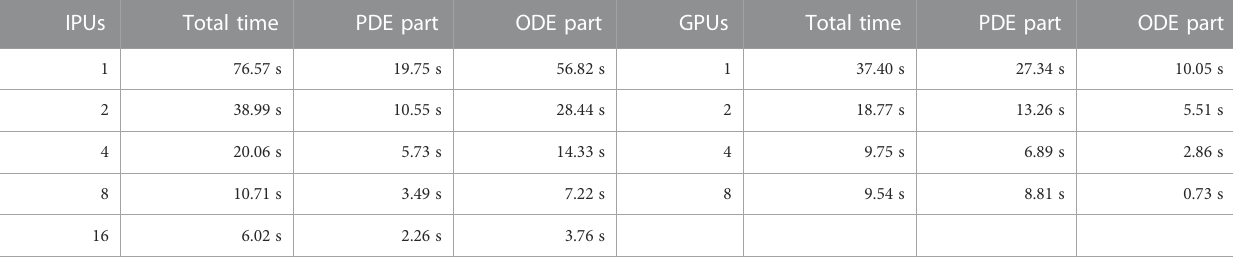
TABLE 3 Performance comparison between GC200 IPUs and A100 GPUs related to a monodomainsimulation using the heart04 mesh with 25,000 ODE steps and 100,000 PDE steps.